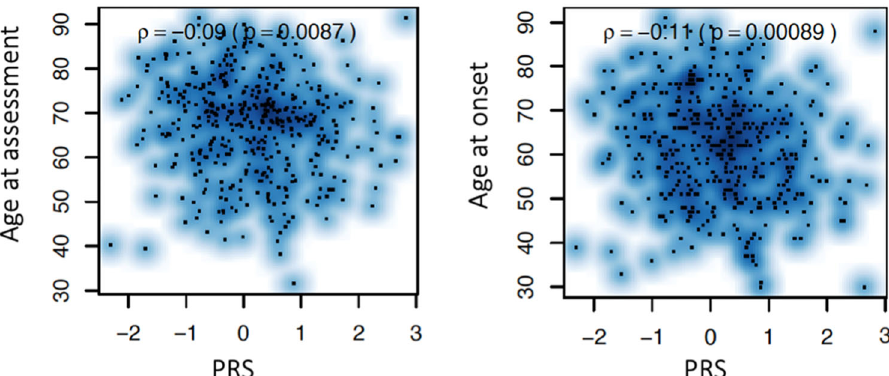
Fig. 2 Pairwise association between age at onset (AAO), age at assessment (AAA) (y-axis) and polygenic risk score (PRS) (x-axis) with Kendall correlation coef fi cient. Signi fi cant inverse association was determined between AAO and PRS and AAA and PRS indicating the younger the AAO of PD, the higher cummulative burden of small effect size variants (represented by PRS).